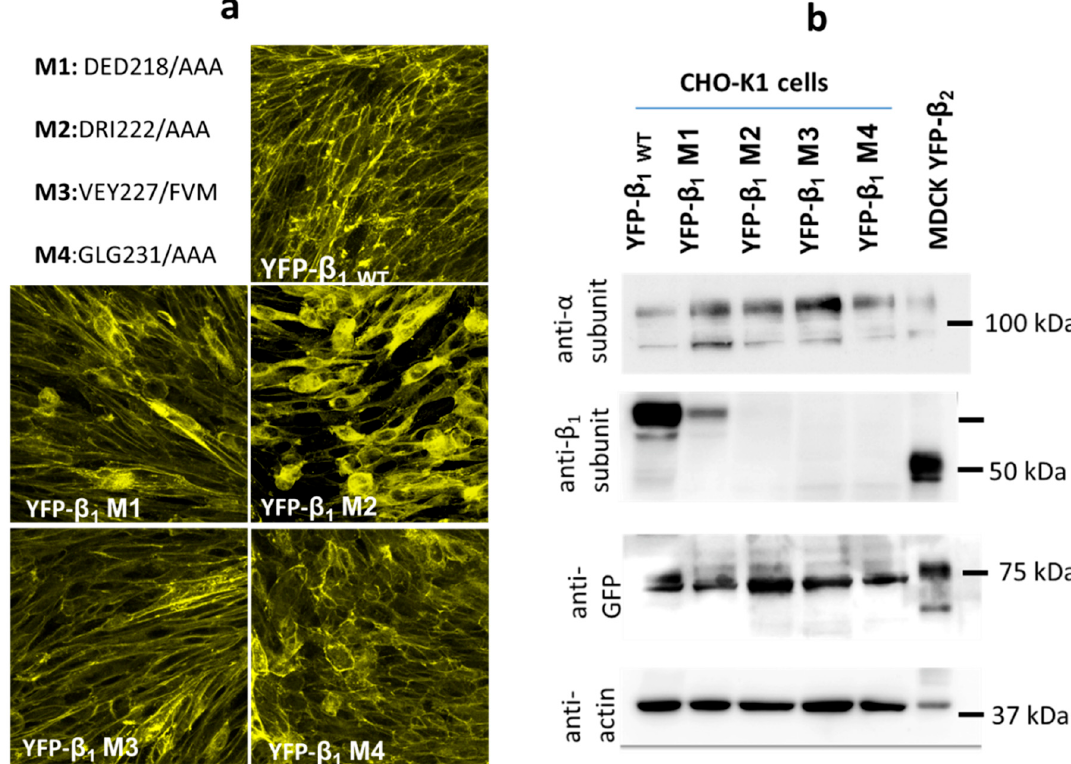
Figure 4. Stable expression of canine YFP- β 1 subunit mutants in CHO fibroblasts. ( a ) Scheme describing the location of the mutated sites. Three consecutive residues were mutated in each case. Images shown correspond to YFP fluorescence from clones expressing each of the mutants in a stable manner. ( b ) Identification of YFP- β 1 fusion proteins by western blot: A band of 110 kDa is detected in lysates from cells stably expressing either YFP- β 1 WT (lane 1) or YFP- β 1 M1-M4 (lanes 2 to 5) or YFP- β 2 subunit, with an anti- α subunit antibody (upper panel). In the second panel, the antibody we have regularly used for detection of the canine β 1 subunit recognizes a band of 75 kDa in cell lysates from YFP- β 1 WT (lane b) and M1 (lane 2), and a band of 50 kDa in a lysate from MDCK cells expressing the transfected YFP- β 2 subunit (lane 6), corresponding to endogenous canine β 1 subunit. That antibody does not recognize the β 1 mutants M2, M3, and M4 (Lanes 3–5). A 75 kDa band is detected with an anti-GFP antibody (third panel) in all lanes. Anti-actin has been used as an internal control (lower panel).